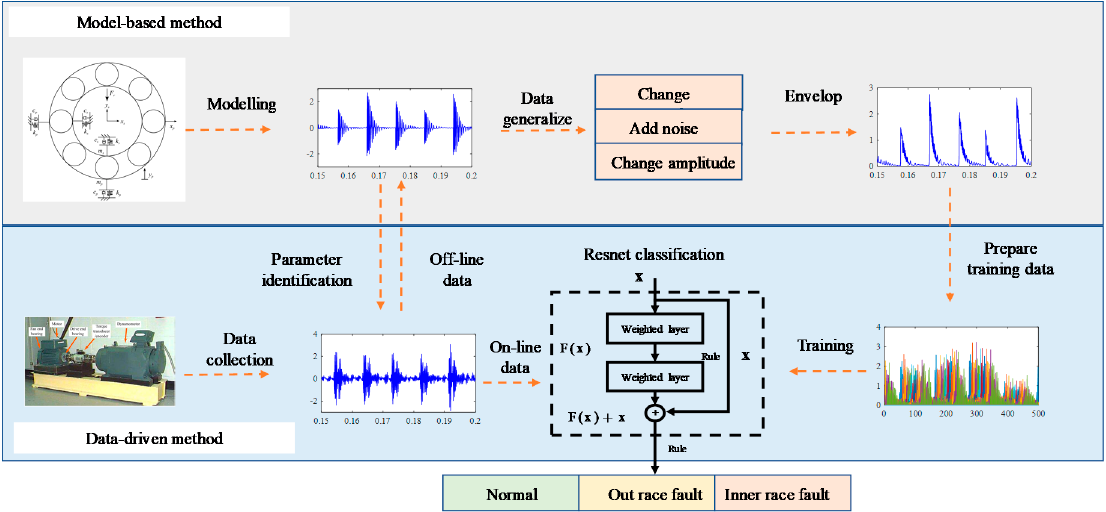
Figure 1. Framework of the fault detection by Resnet classifier with model-based data augmentation.